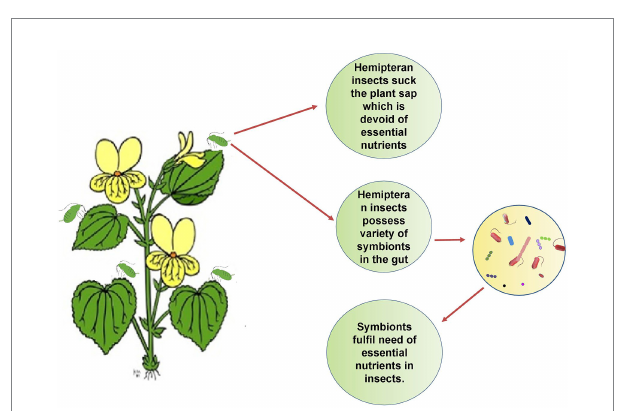
FIGURE 3 Symbionts help in the provision of essential nutrients: Plant sap does not provide the complete ingredients of the diet, so hemipteran insects are dependent on gut symbionts to get essential